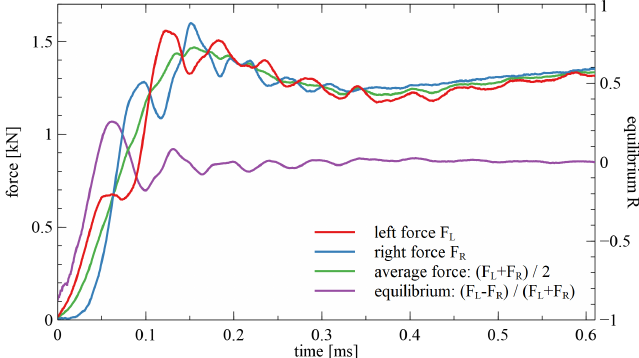
Figure 4: Individual force signals on input and output bar and their average as well as the ratio of forces indicating force